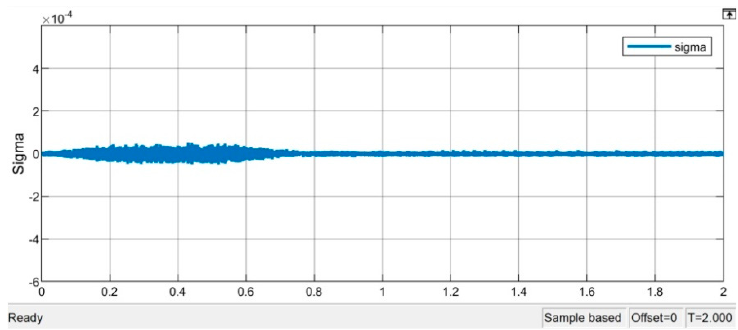
Figure 9. The response of sliding surface σ without load.